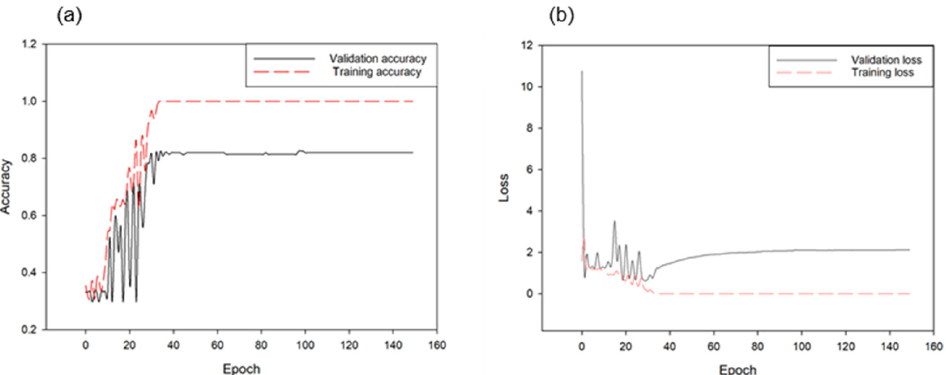
Figure 12. Accuracies of training and validation through the CNN model for behavioral classification of four cattle voices ( a ) and corresponding loss changes ( b ) (1.0 in this graph is 100% accuracy).